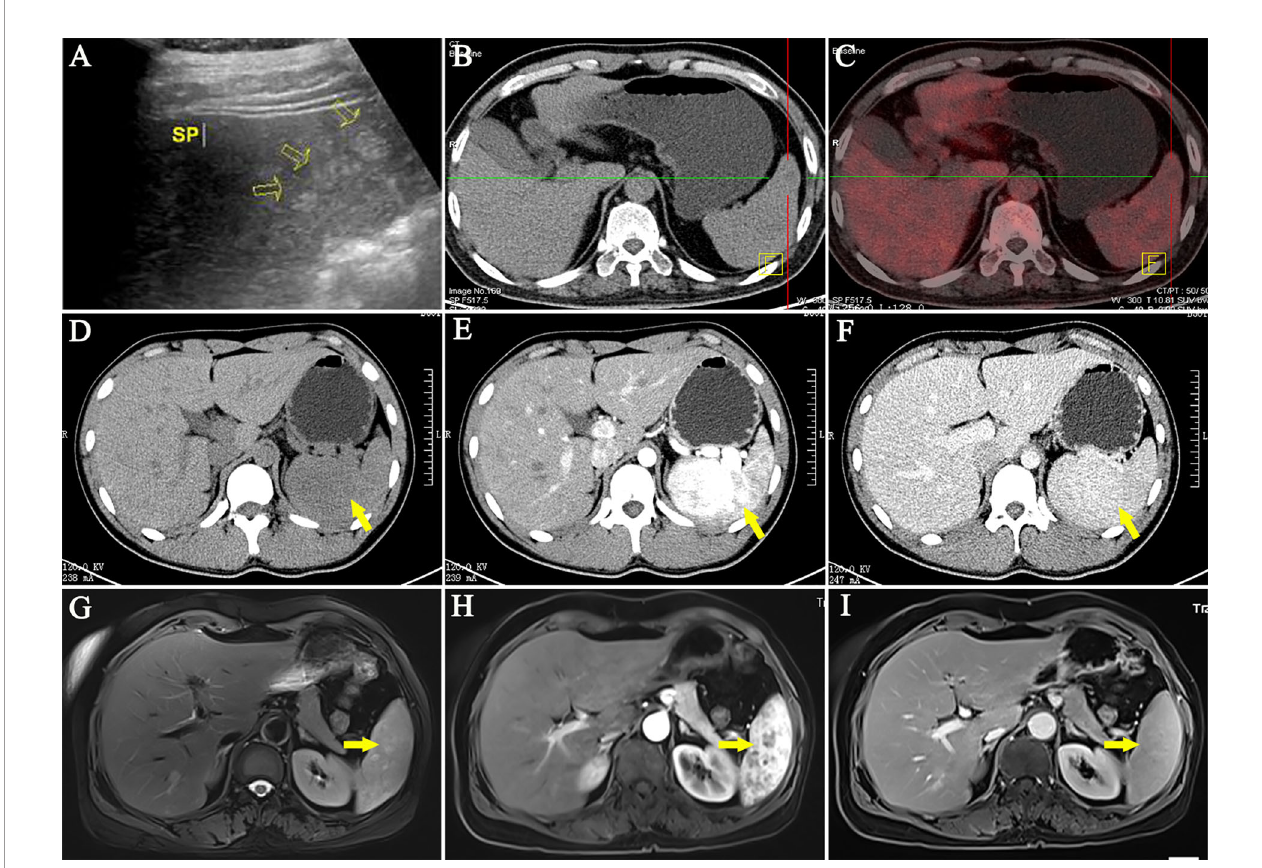
T2WI, the splenic lesions mostly manifested as a high signal intensity. (H, I) Similar to contrast-enhanced CT, Enhanced MRI showed a delayed enhancement.